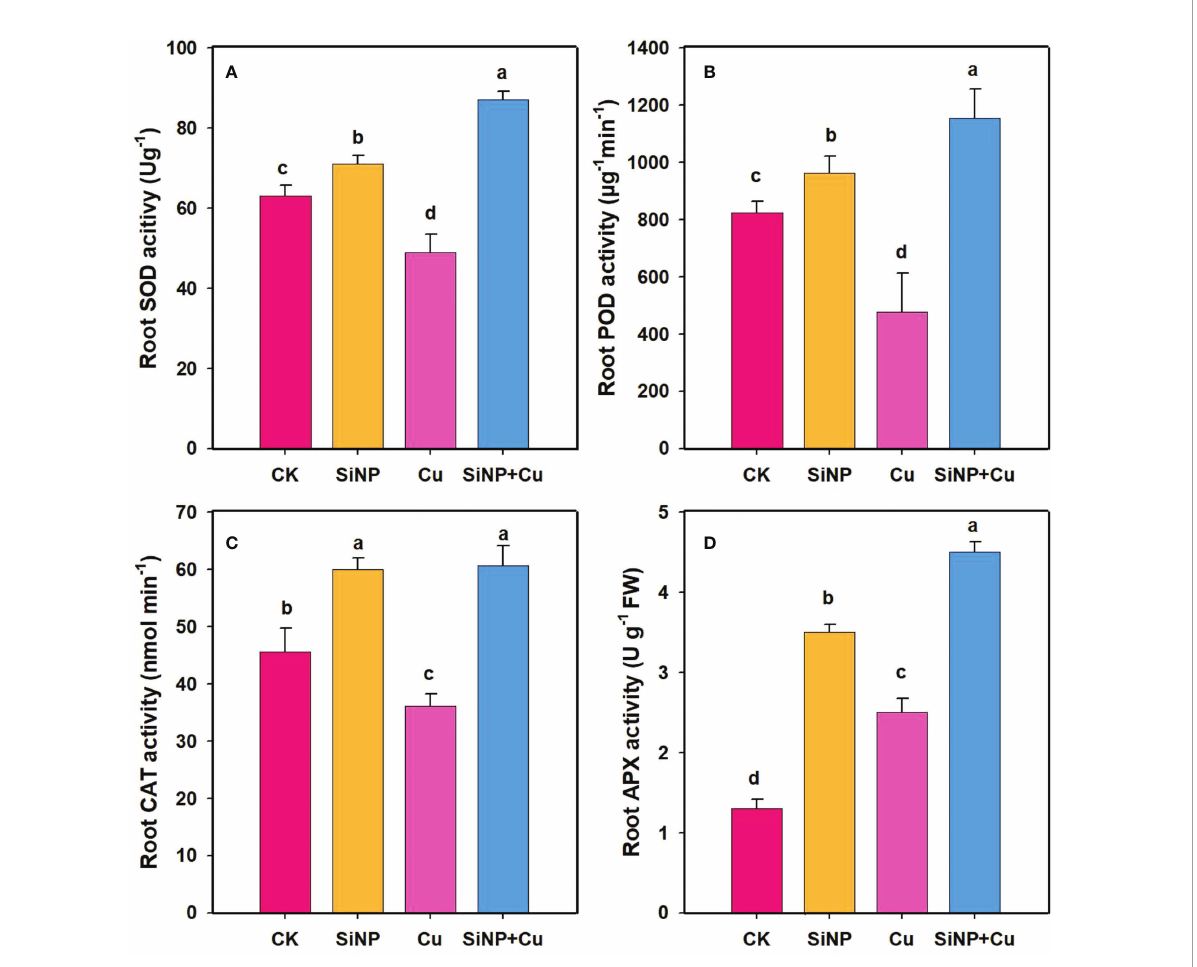
FIGURE 5 Enzymatic activities under Cu 2+ stress. Note “ Experimental treatments contained: CK (control); SiNP (2.5 mM SiNPs); Cu (500 µM Cu 2+ alone), SiNP+Cu (2.5 mM SiNPs+500 µM Cu 2+ ). The different letters (a, b, c, d) describe the differences in different treatments by LSD test at (P ≤ 0.05) ” . (A) SOD, (B) POD, (C) CAT, (D)